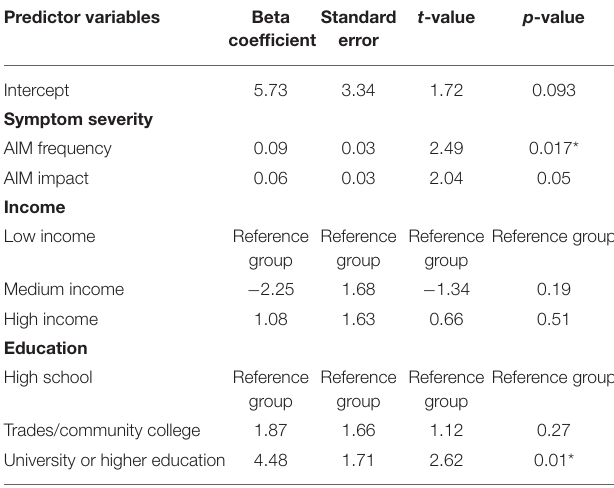
TABLE 4 | Model 3: multiple linear regression of family life, AIM frequency, AIM impact, and socioeconomic